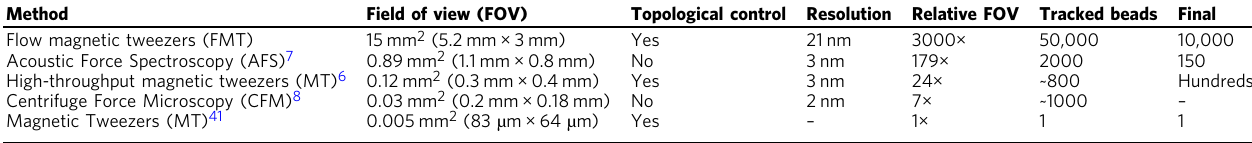
Table 1 Throughput of force spectroscopy